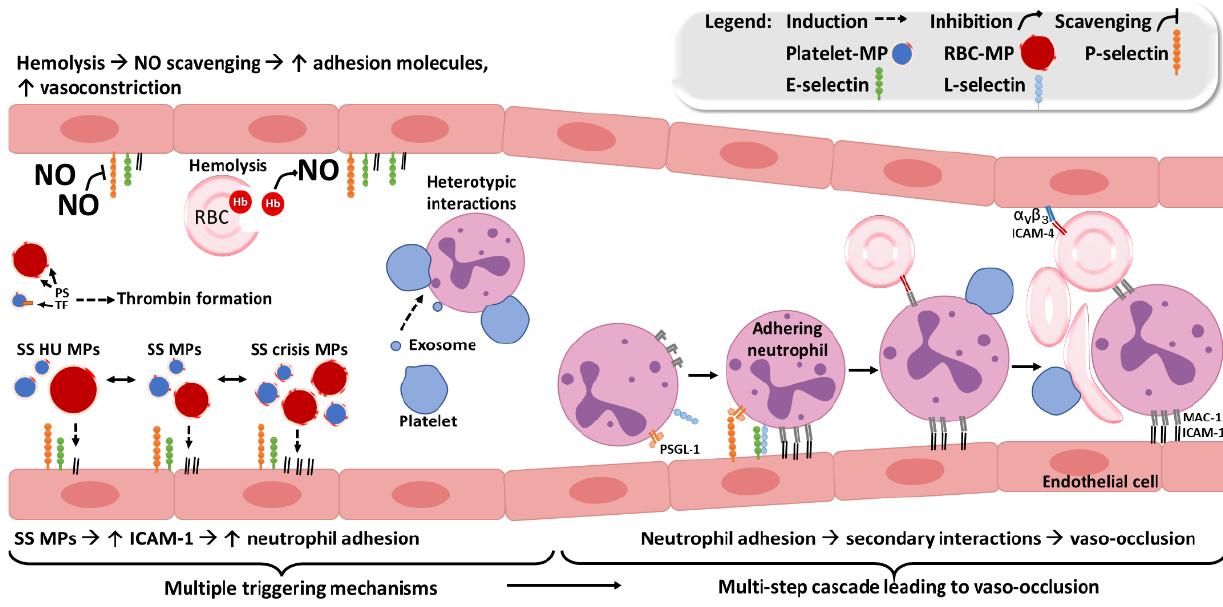
Figure 4. Actors contributing to the occurrence of vaso-occlusions in SCA. Multiple triggering mechanisms lead to a pro-coagulant, a pro-adhesive, and a vasoconstrictive state in SCD. They are partly due to phosphatidylserine (PS) and tissue factor (TF) increased expression by MP, to MPs-mediated increase of endothelial intercellular molecule-1 (ICAM-1) expression and to nitric oxide (NO) decreased bioavailability, respectively. In this context, neutrophils can abnormally adhere to the activated vascular endothelium. Next, secondary interactions with erythrocytes and platelets can lead to a vaso-occlusion, a key event leading to vaso-occlusive crises (VOCs).